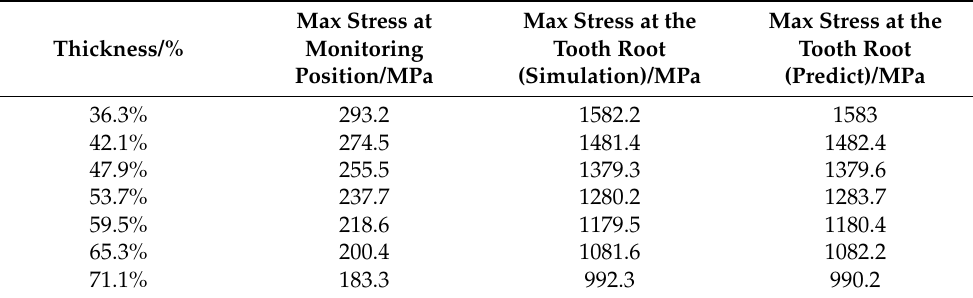
Table 15. Max stress at the monitoring position and the back of the spoke at 4th ND resonant rotational speed at different thickness of spoke plate.